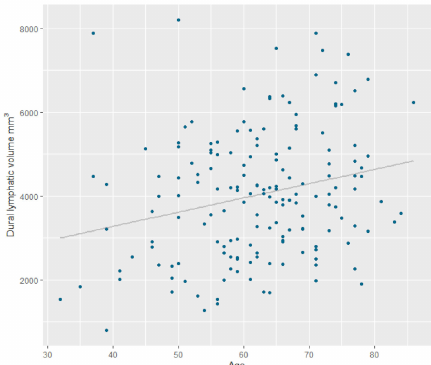
Figure 4. Scatter plot displaying the relationship between dural lymphatic vessel volume and